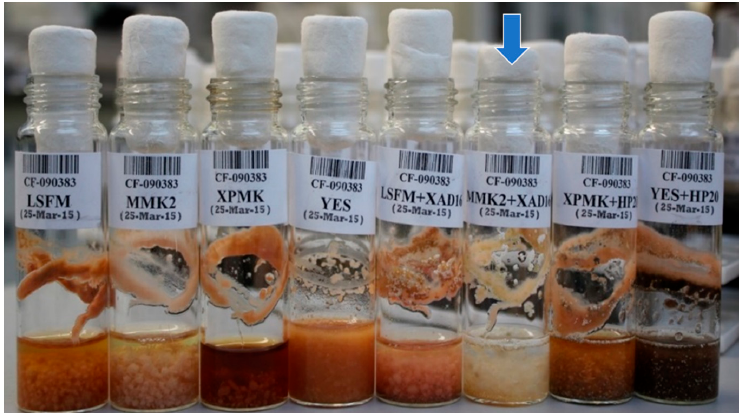
Figure 2. Fungal strain D. tragani CF-090383 grown in LSFM, MMK2, XPMK, YES, LSFM+XAD-16, MMK2+XAD-16, XPMK+HP-20 and YES+HP-20 media. After 14 days, phenotypic differences in color, morphology and biomass were detected. The blue arrow shows the fermentation condition (MMK2+XAD-16) that showed the production of antifungal and cytotoxic activity against the panel used in this study.